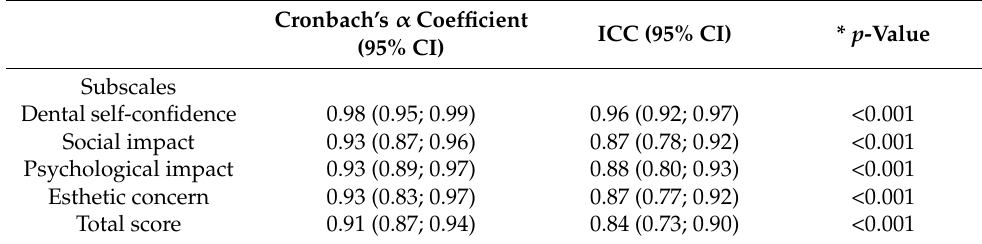
Table 1. Test–retest reliability using ICC for the